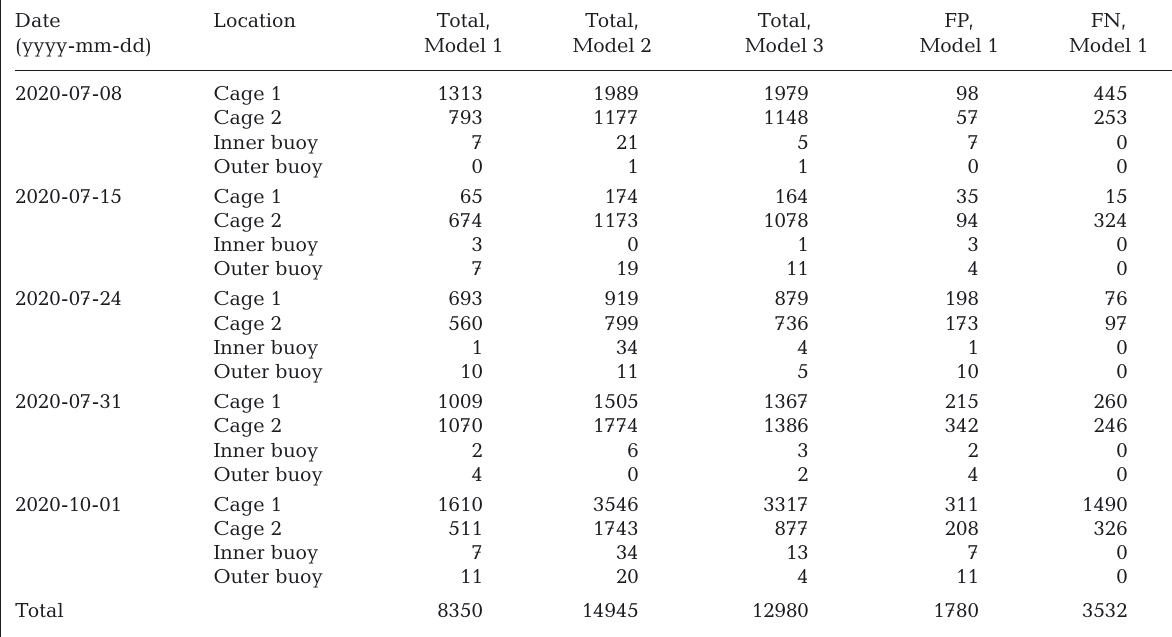
test set, FP and FN rates were 17.8 and 5.8%, respec-